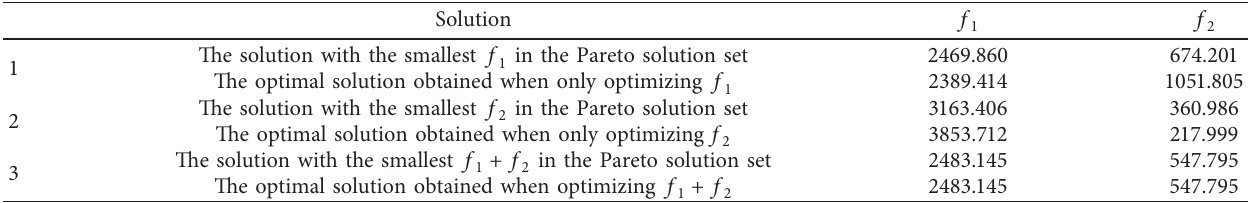
Figure 6: Single-objective optimization results of Instance I. (a) The results when only optimizing f + f f . (c) The results when optimizing f . 2 1 2 Table 5: Comparison of single-objective optimization and Pareto solution set for Instance I.